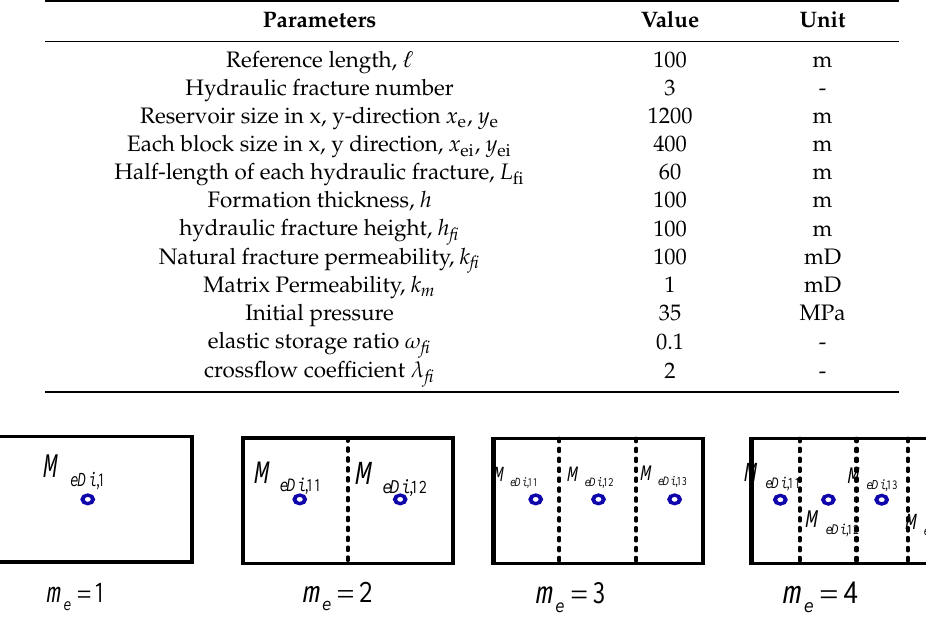
Figure 3. Di ff erent discretization schemes at the block interfaces. Figure 3. Different discretization schemes at the block interfaces. Table 2. Comparison of the model results with di ff erent segments of block interfaces.